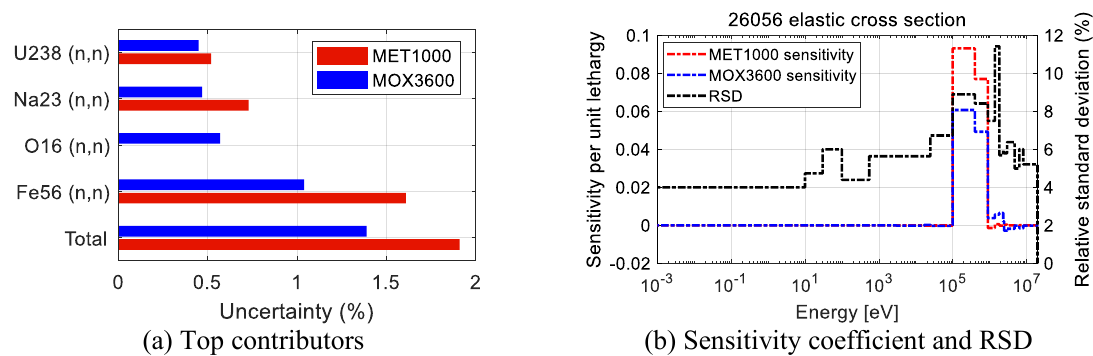
Figure 8. Uncertainty contributions to 𝚺